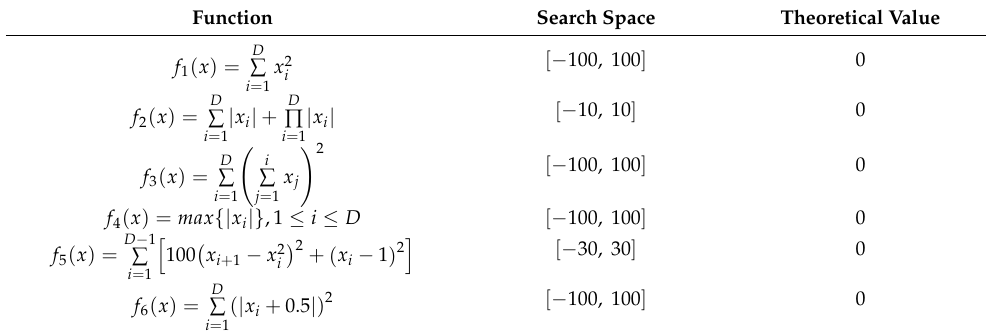
Table 1. The test